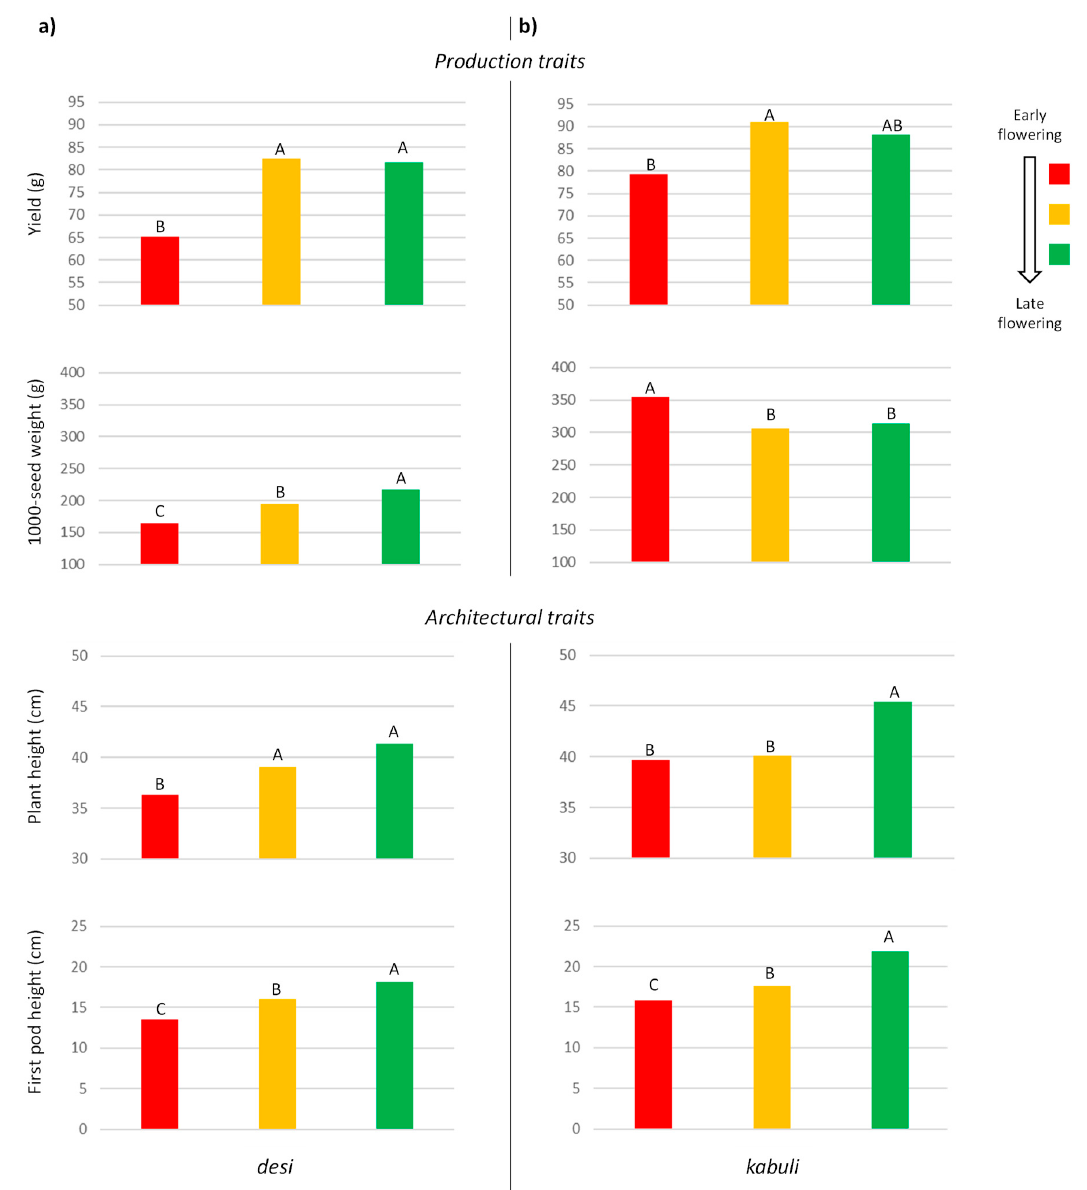
Figure 6. One-way ANOVA across the flowering groups of the UNIVPM_Ca_core2 panel for production (yield, 1000-seed weight) and architectural (plant height, first pod height) traits for the desi ( a ) and kabuli ( b ) types. Data are means for each cluster. Di ff erent capital letters above the columns in each plot indicate significant di ff erences between clusters for that trait ( p < 0.05; Student’s t -tests).